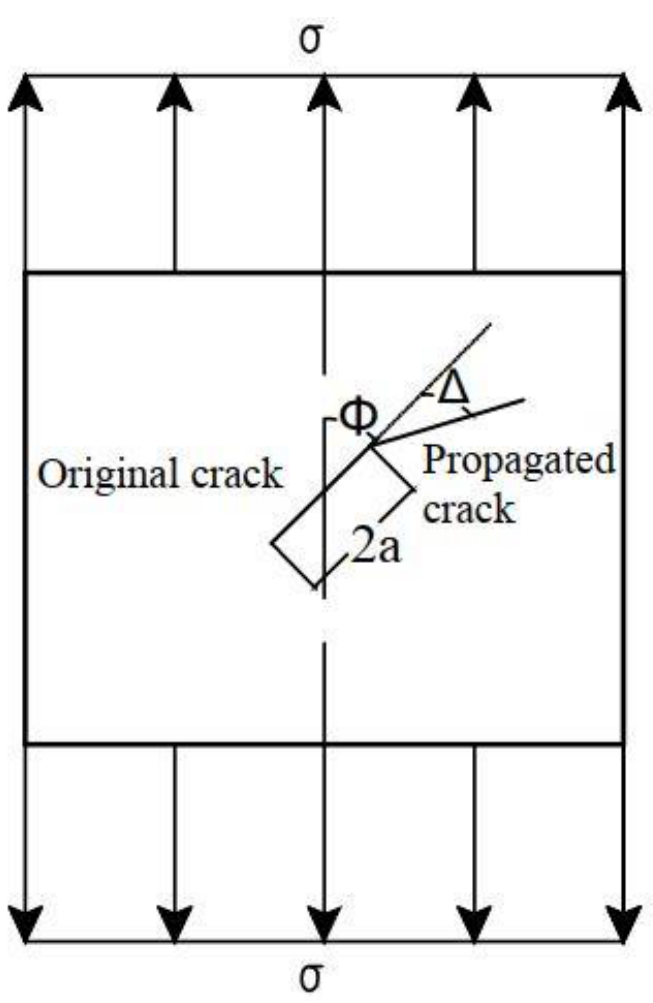
Figure 4. Oblique crack model subjected to tension.